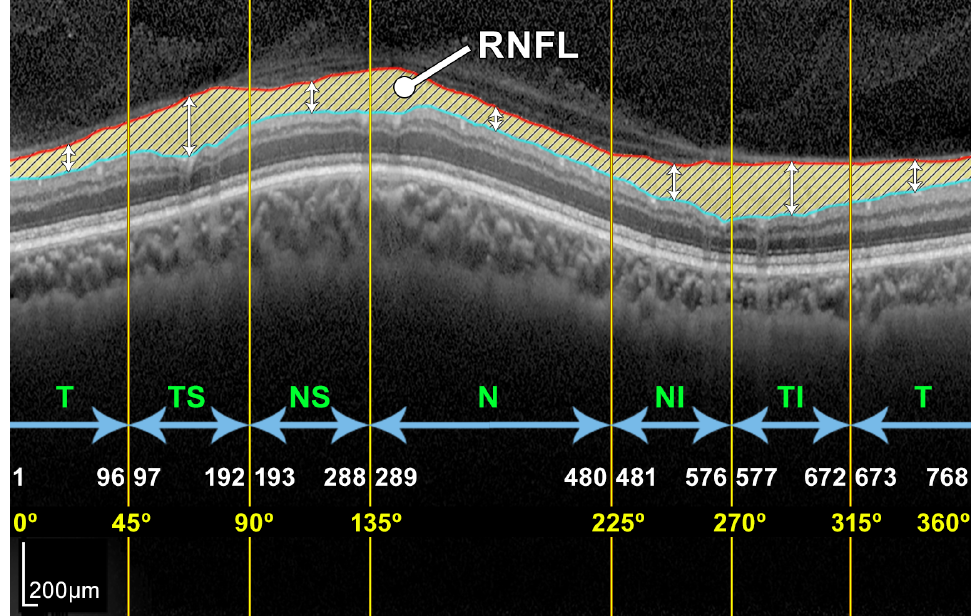
Figure 3. Example of a peripapillary B-scan OCT image with the manual segmentation of the layer of interest RNFL and description of the sectors: T, TS, NS, N, NI, and TI.